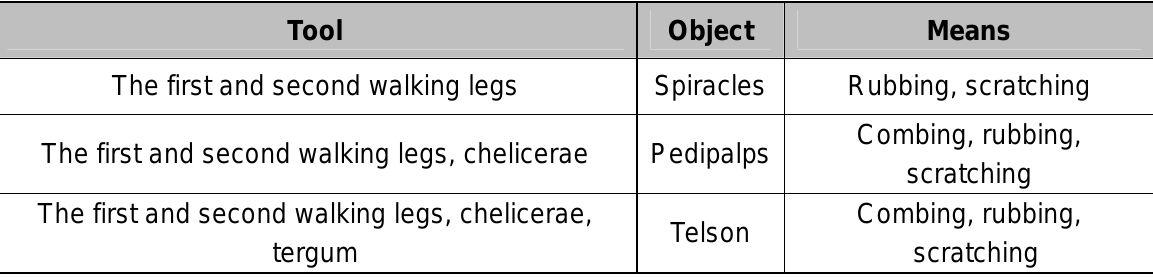
Table 2. Cleaning behaviors displayed during daily activity in Scorpiops luridus